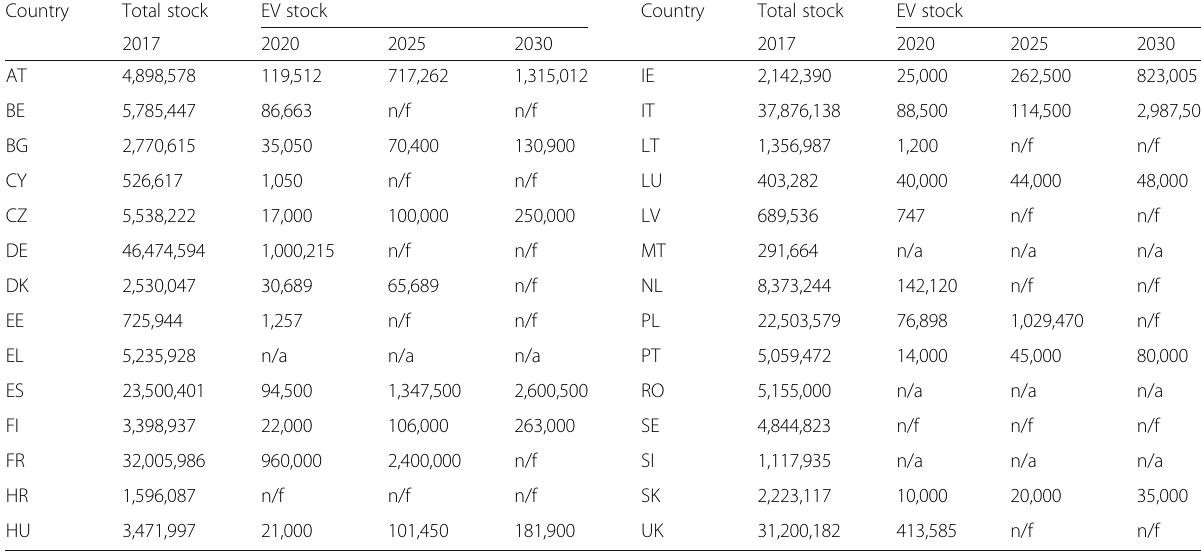
Country Total stock EV stock